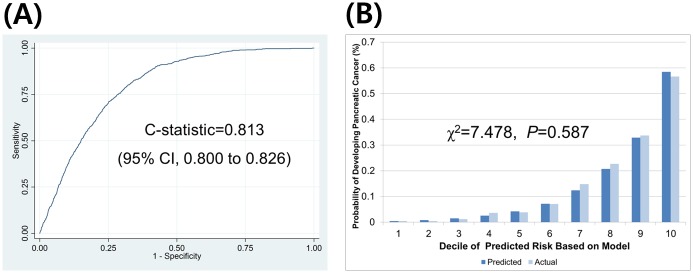
Discrimination and calibration ability of the pancreatic cancer prediction model in men as assessed in an external validation set (n = 500,046, events = 711).(A) discrimination ability and (B) calibration ability.